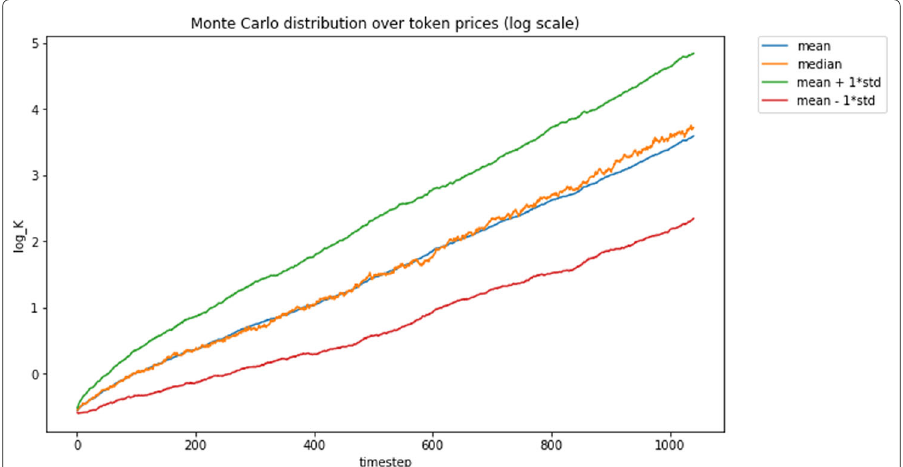
Fig. 3 Token prices over 1,040 weeks; statistics from 100 Monte Carlo Runs under smooth exponential decay block reward schedule on log